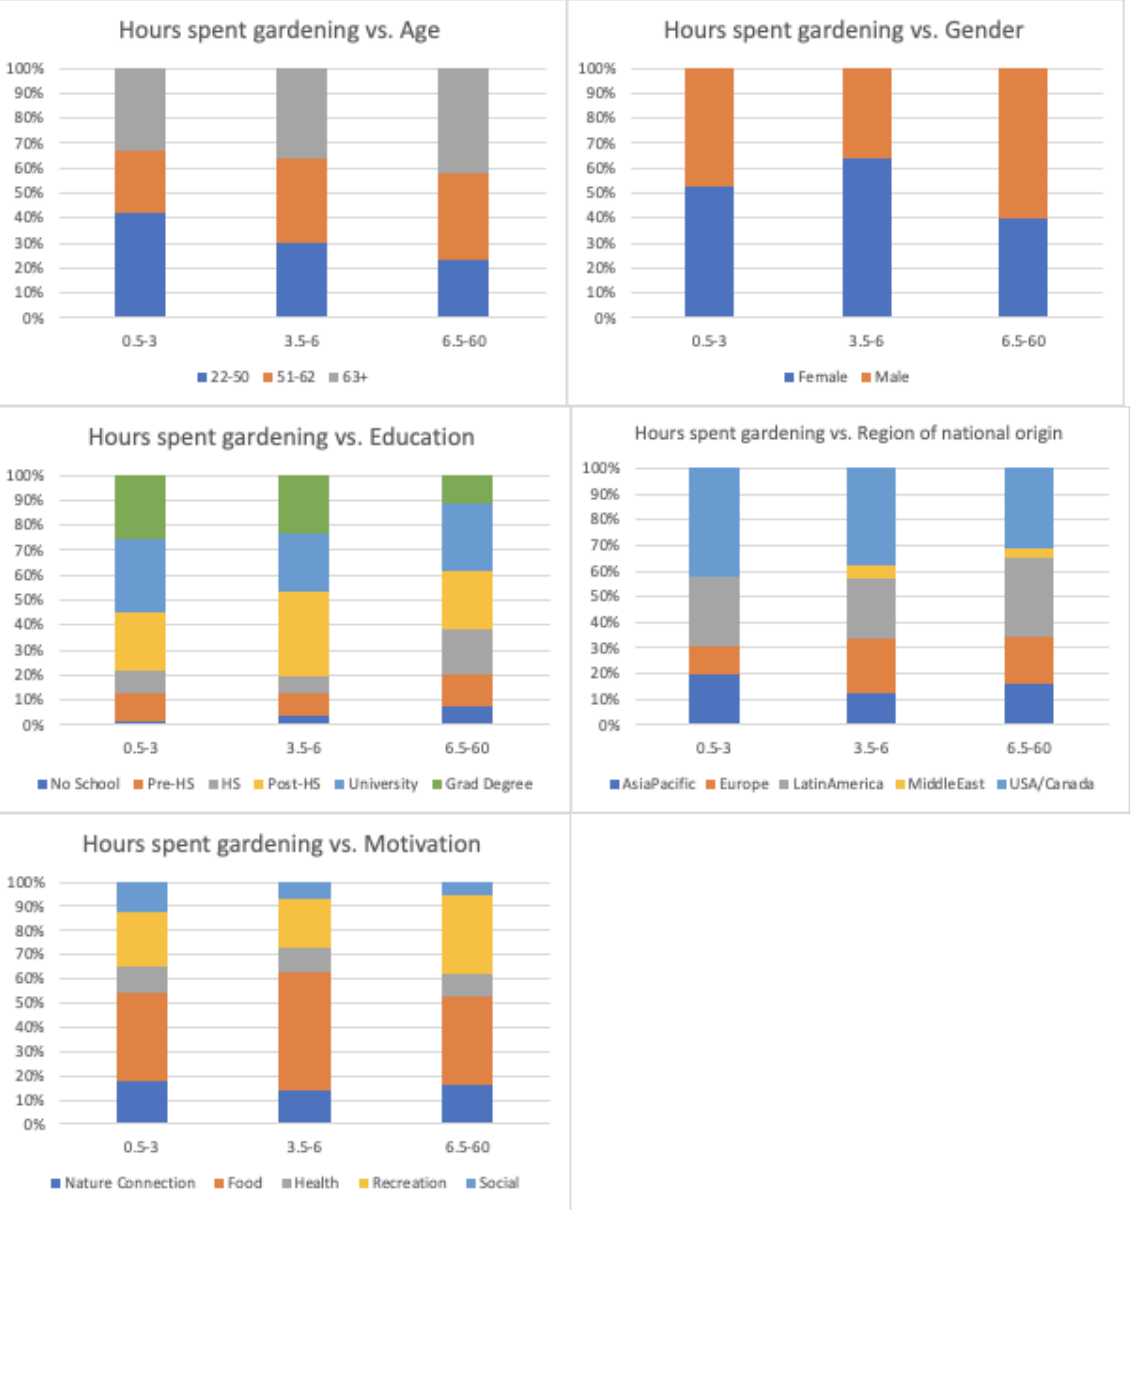
Figure A2.6. Relationships between hours spent gardening and gardener age, gender, education, region of national origin, and motivations for